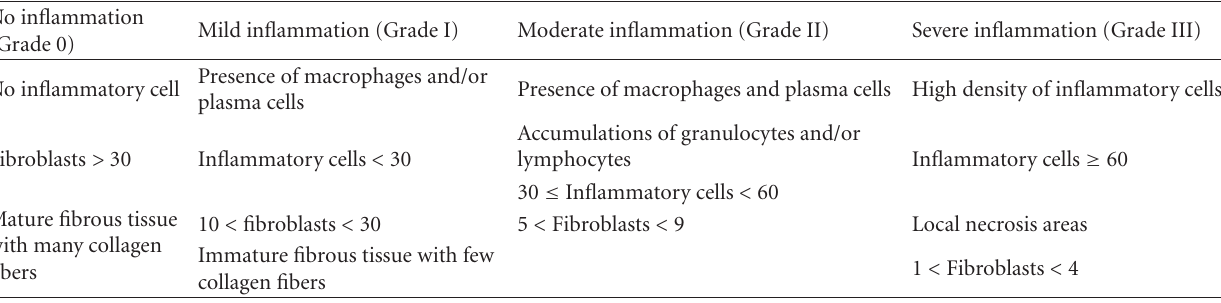
Table 3: Criteria for Scaling of inflammation degrees.